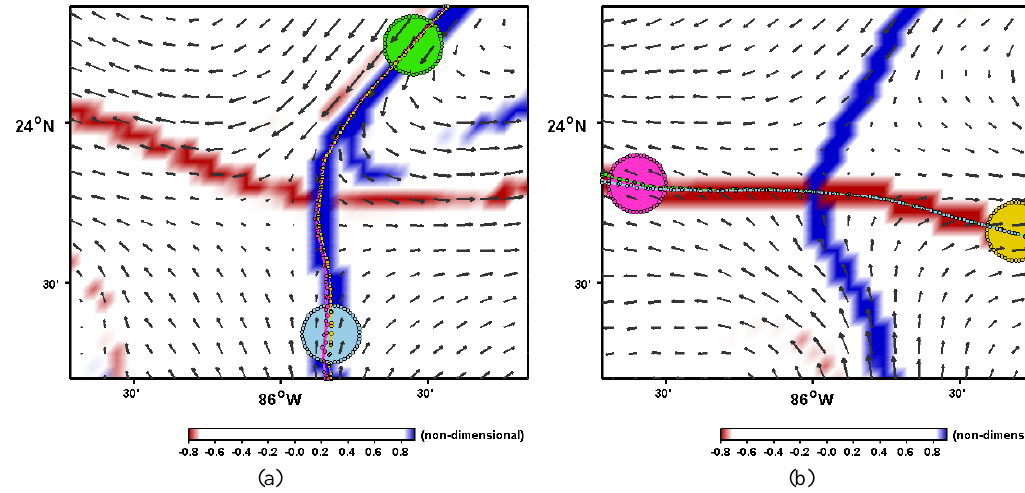
Fig. 5. Same as Fig. 3 except at 150m.